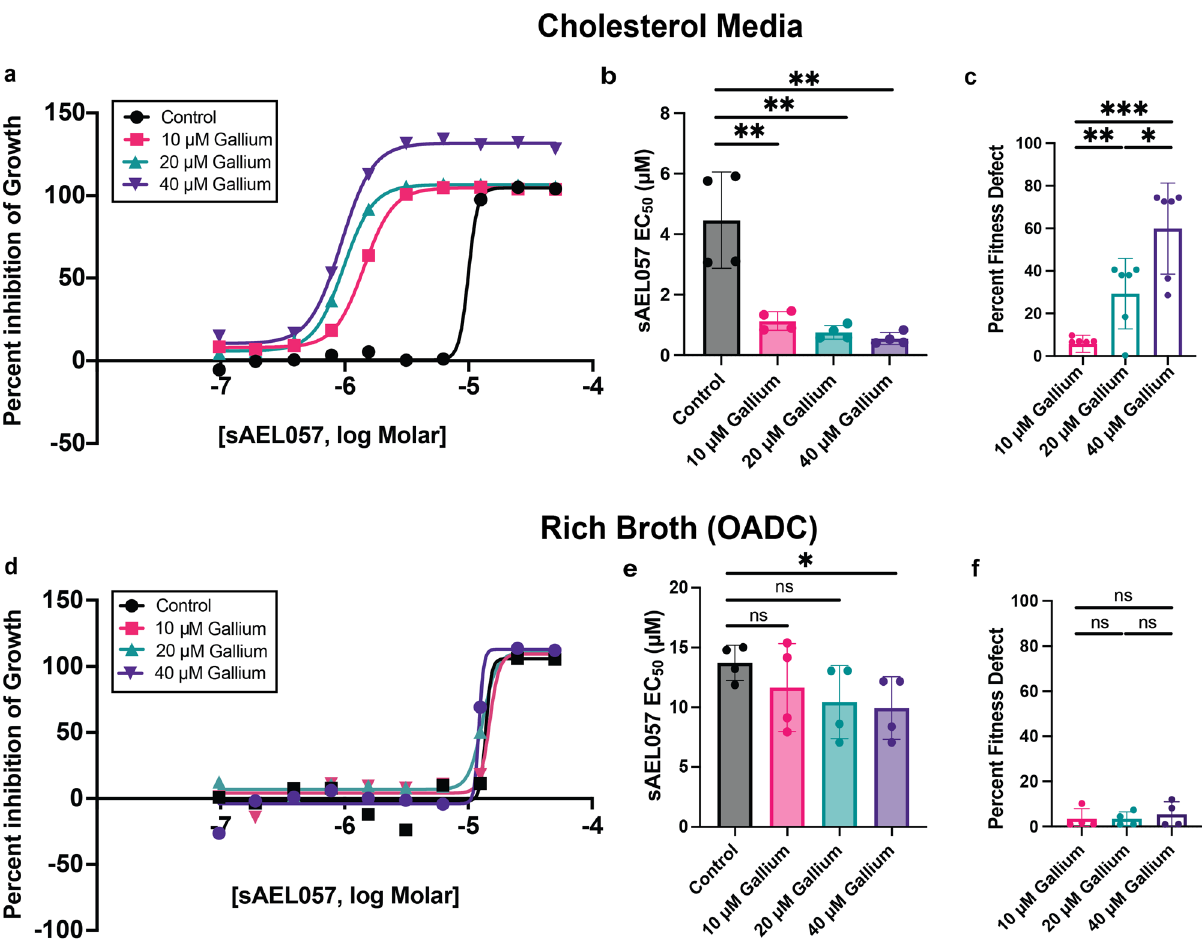
Fig. 3 Gallium addition synergizes with sAEL057 treatment to inhibit Mtb growth in cholesterol media but not in rich broth. Mtb were grown in cholesterol-supplemented media ( a – c ) or rich broth ( d – f ) and treated with sAEL057 at 50 µ M down to 0.097 µ M in a dose curve-dependent manner. Alamar blue was added at day 9 and results were measured via fl uorescence on day 10. a , d Representative graphs of percent inhibition curves.